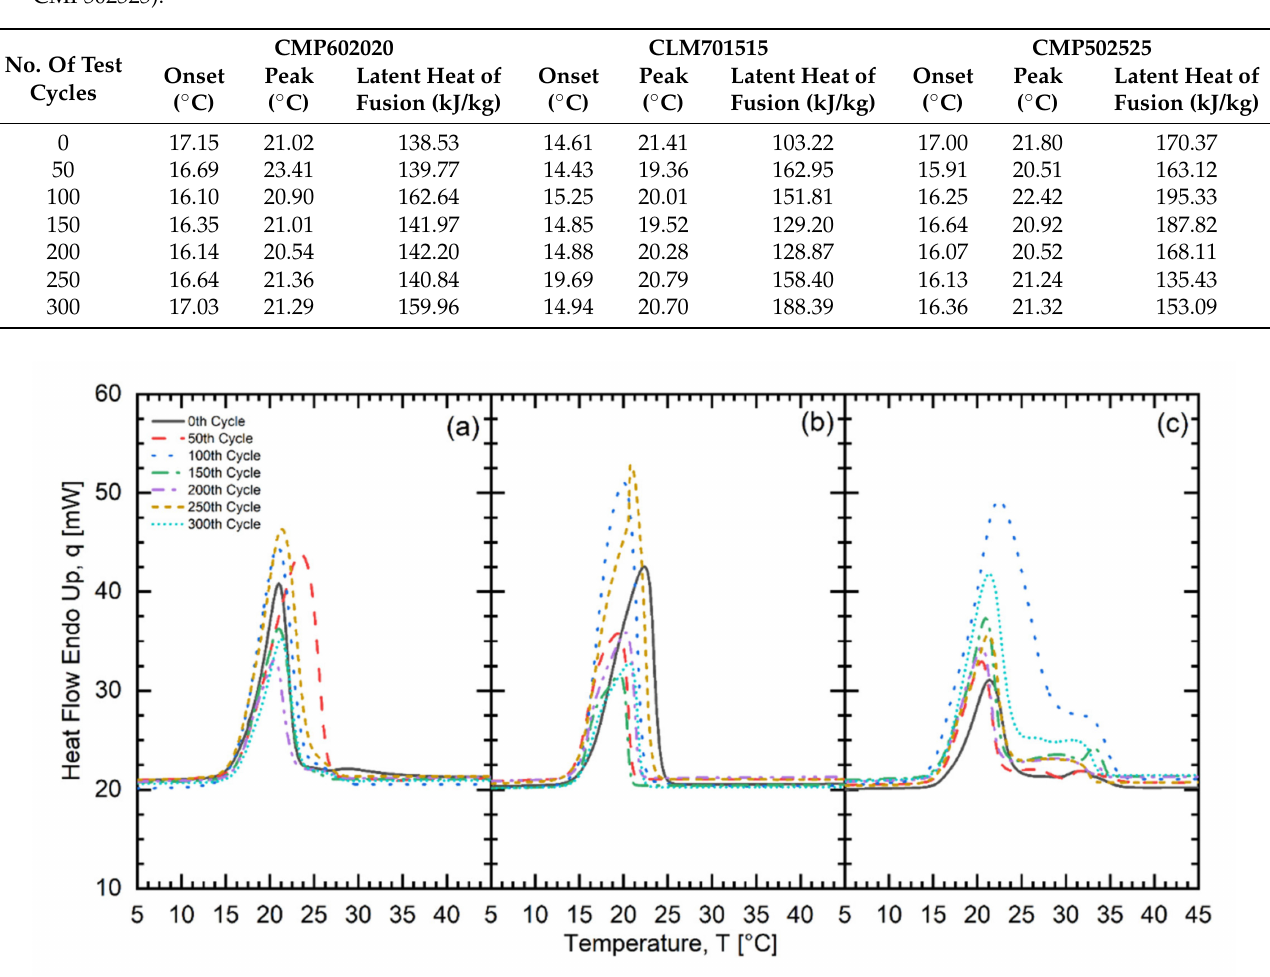
Table 6. Latent heat of fusion and melting temperature of developed materials with test cycles (CMP602020, CLM701515, CMP502525).